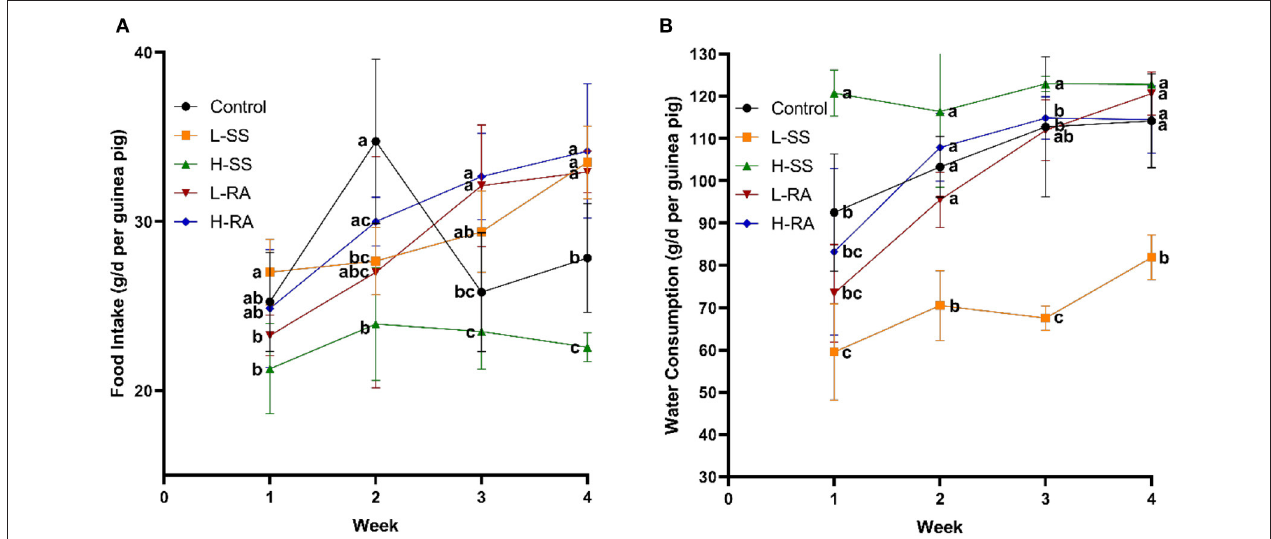
FIGURE 1 | Effect of dietary non-nutritive sweetness drinking on food intake and water consumption in male guinea pigs. Animals in the control, L-SS, H-SS, L-RA, and H-RA groups were supplied water solution with normal water, 1.5mM sodium saccharin, 7.5mM sodium saccharin, 0.5mM rebaudioside A, and 2.5mM rebaudioside A for 28 days, respectively. Each point in figures represents average daily food intake (A) and water consumption (B) per week. Data are shown as means ± SD ( n = 6). Points in the same vertical line with different letters denote significant differences ( P < 0.05).